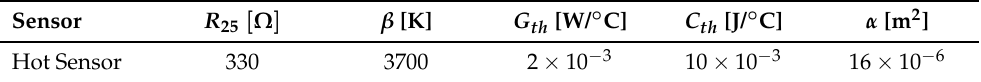
Table 5. CT Wheatstone bridge architecture sensor parameters used in SPICE simulation.